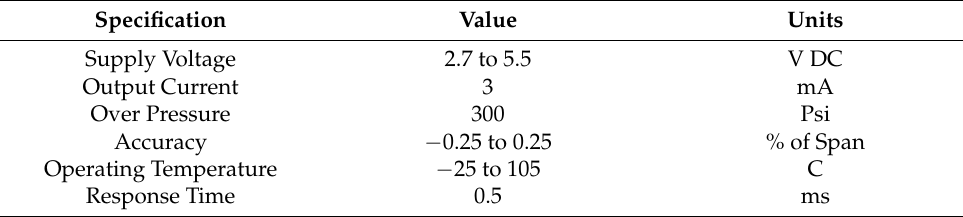
Table 3. Technical Specification of pressure sensor [33].